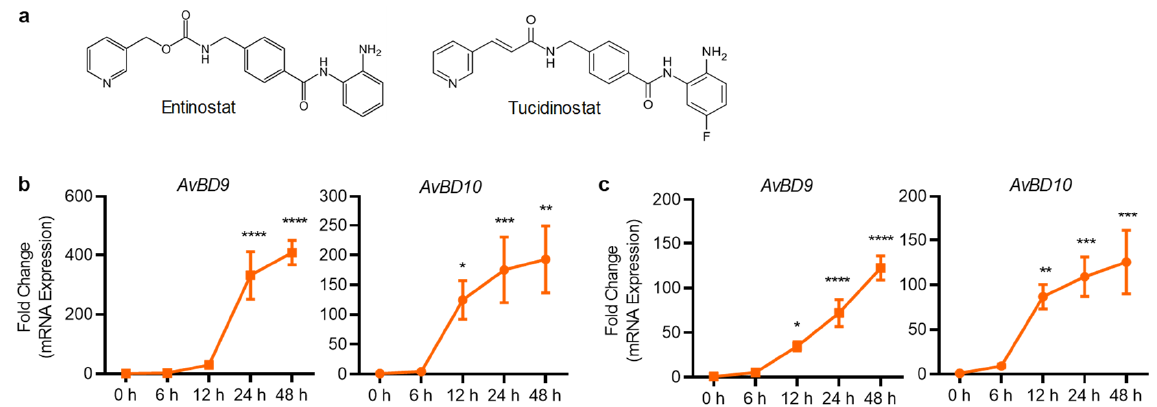
Figure 6. Time-dependent induction of AvBD9 and AvBD10 mRNA expression in chicken HTC cells in response to structurally-related entinostat and tucidinostat ( a ). HTC cells were stimulated in duplicate with 10 µM entinostat ( b ) or tucidinostat ( c ) for 6, 12, 24, or 48 h, followed by RT-qPCR analysis. The results are means ± SEM of 2–3 independent experiments. * p < 0.05, ** p < 0.01, *** p < 0.001, and **** p < 0.0001 relative to the non-stimulation control (by one-way ANOVA and post-hoc Dennett’s multiple comparisons test).